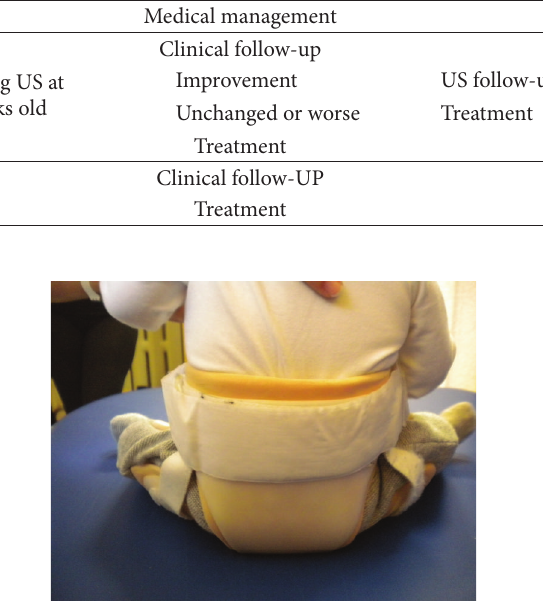
Figure 4: Brace on the child, view from